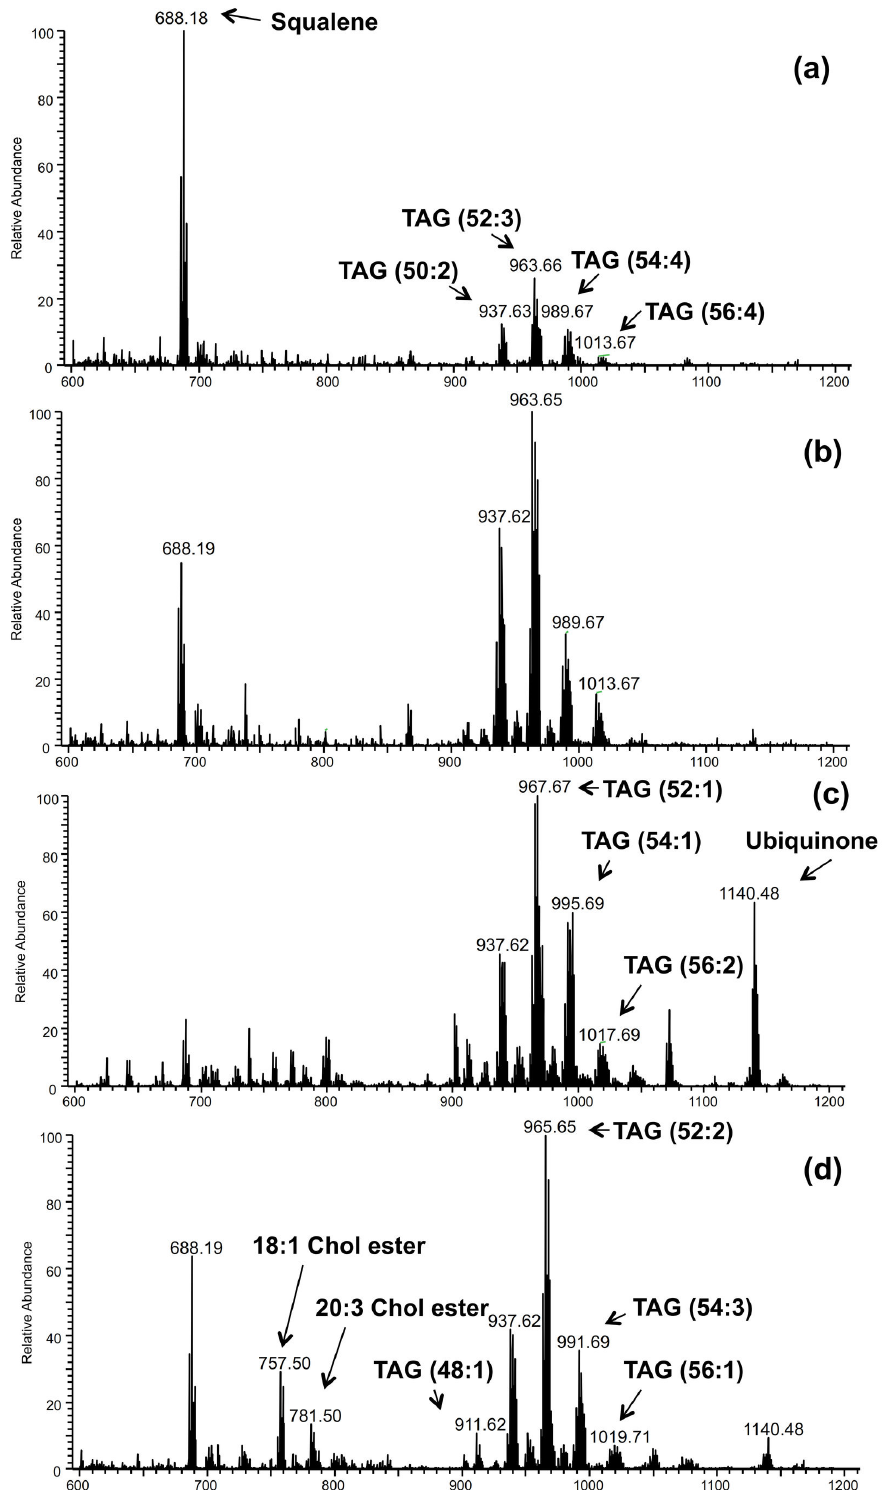
Figure 1. Representative high resolution DESI-MS mass spectra in the positive ion mode. ( a ) immature oocyte; ( b ) in vitro matured oocyte; ( c ) blastocyst produced in vitro ; ( d ) blastocyst produced in vivo . See text for basis for tentative lipid class assignments of the major peaks. doi: 10.1371/journal.pone.0074981.g001 PLOS ONE |